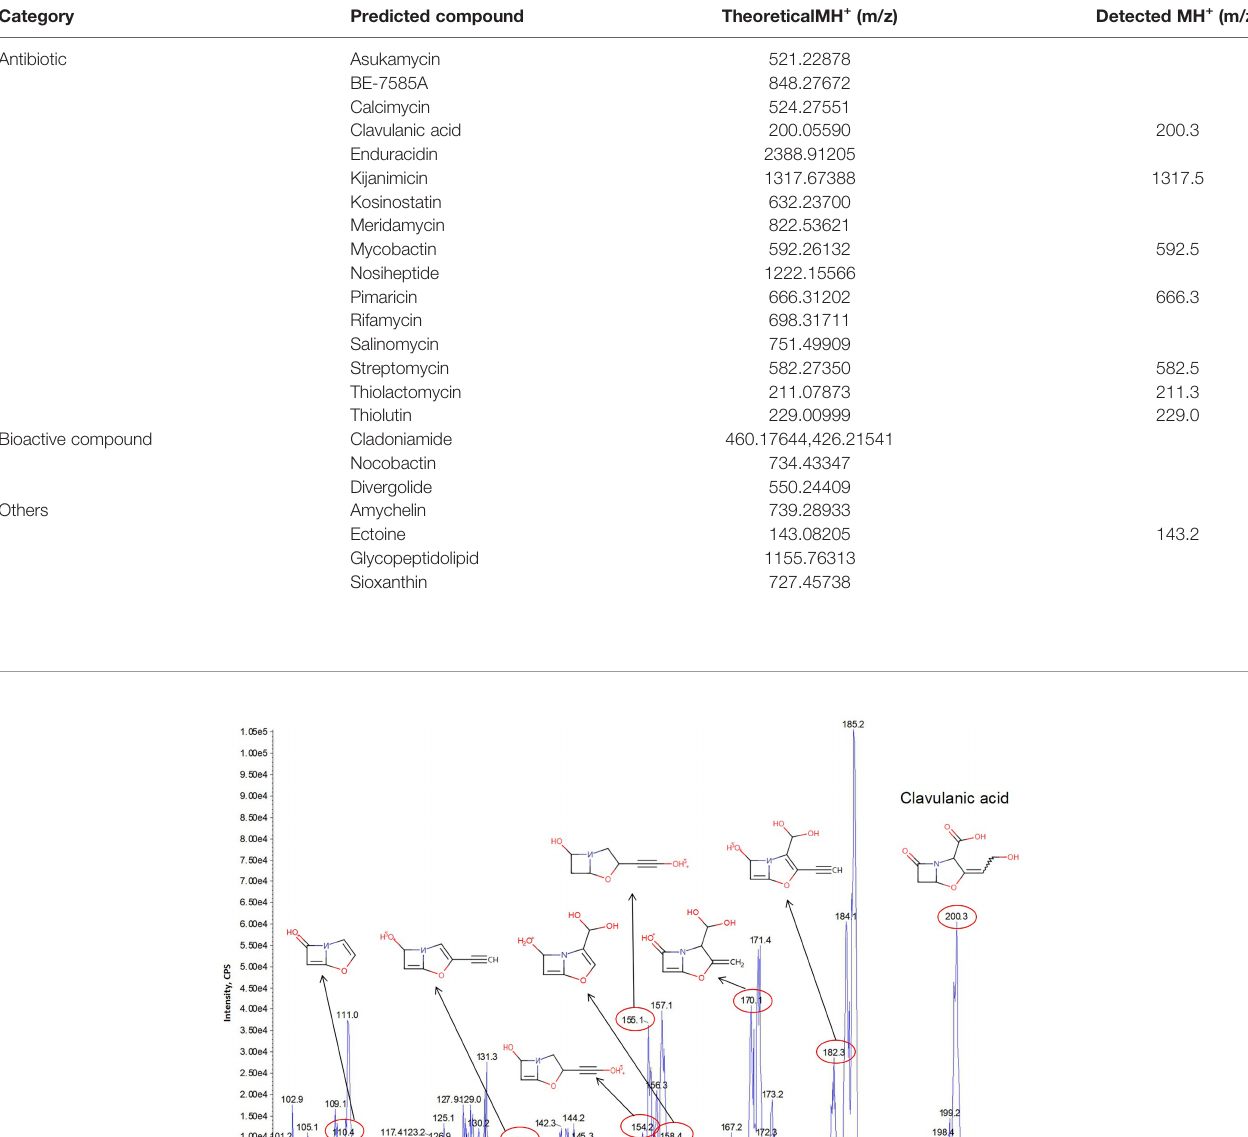
TABLE 2 | Theoretical and detected m/z values for potential secondary metabolites from the M. saopaulense